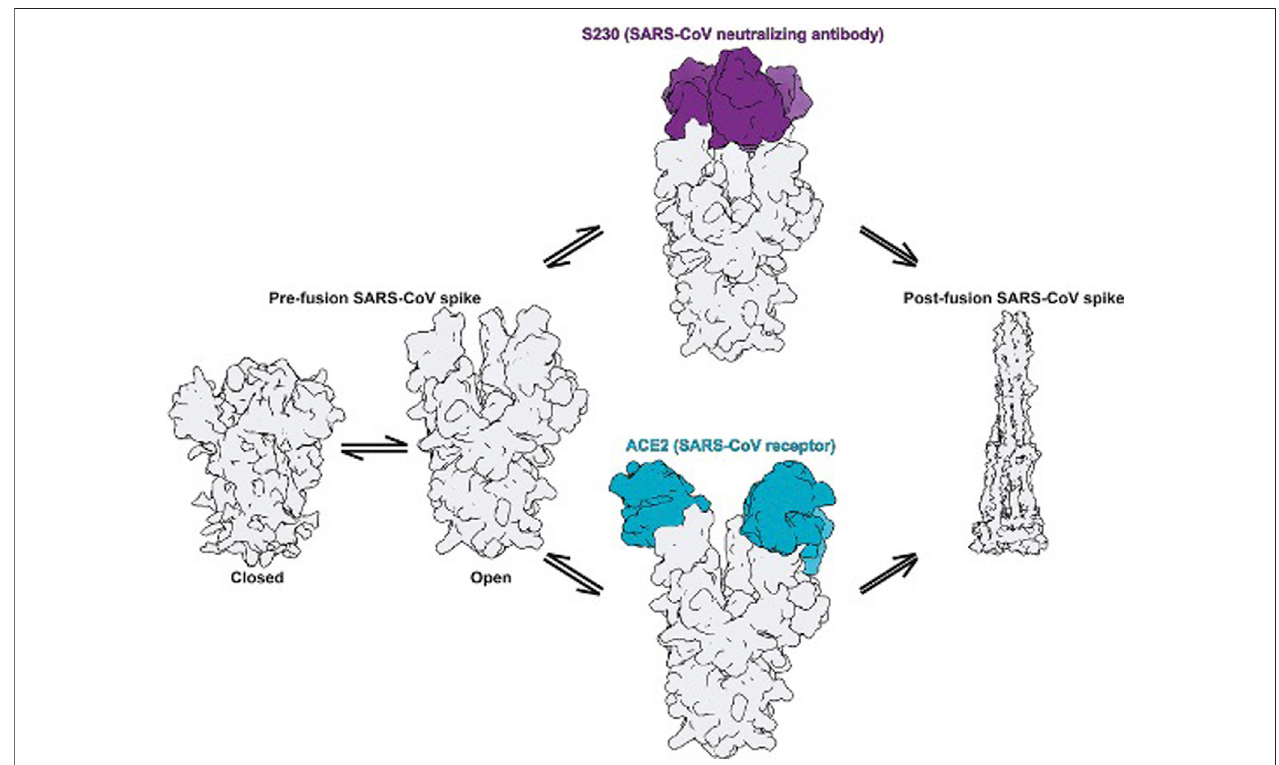
FIGURE4| FusionstatesintheSproteinelucidatethemechanismofactivation[(Wallsetal.,2019)Copyright©2020ElsevierInc.,basedonthereuseprovisionsof Elsevier ’ s COVID-19 Resource Center].